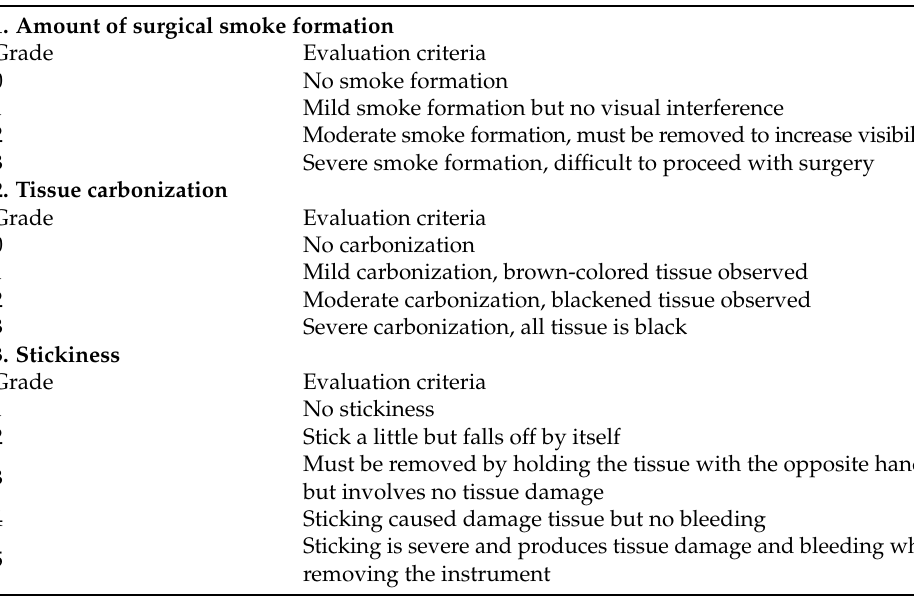
Table 1. Criteria in the surgeon’s experience during laparoscopic